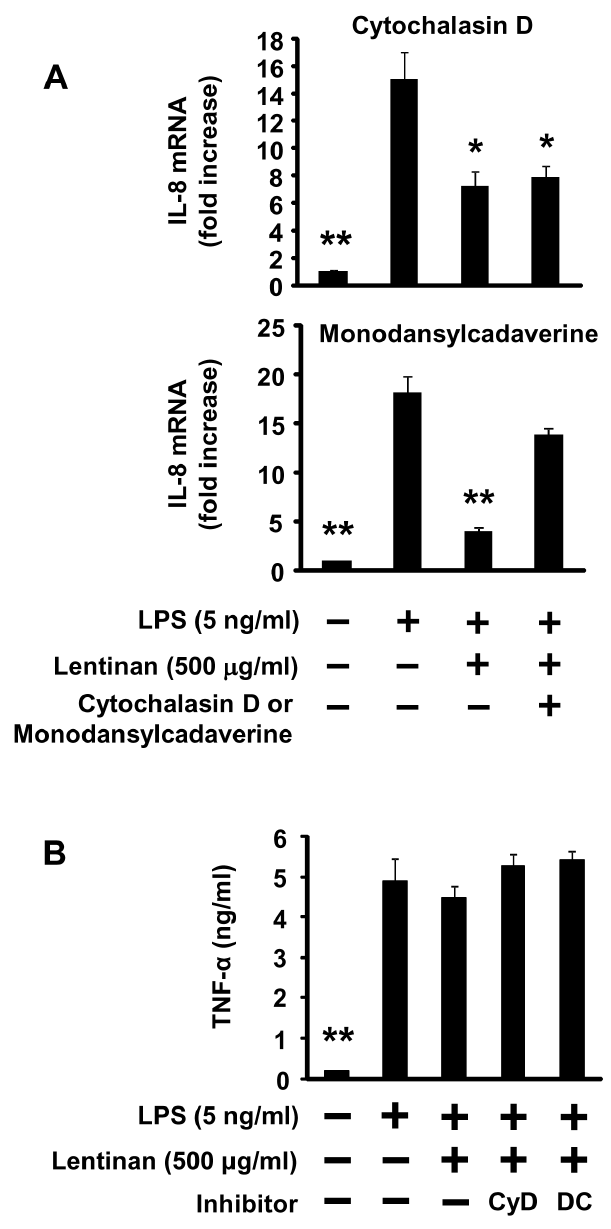
Figure 5. Effect of endocytosis inhibitors on lentinan inhibition of IL-8 mRNA expression in Caco-2 cells. Before co-culturing with RAW264.7 cells, Caco-2 cells on transwell membrane were treated with endocytosis inhibitors, cytochalasin D (2 m M) or monodansylcadaverine (100 m M), for 30 min. Caco-2 cells were washed three times with PBS, and then the cells were used in a co-culture model. Lentinan (500 m g/ ml) was added into the apical compartment of a co-culture model for 3 h. Subsequently, LPS was added to the basolateral compartment at a concentration of 5 ng/ml, followed by incubation for an additional 3 h. IL-8 mRNA expression in Caco-2 cells was determined by quantitative RT-PCR. (B) TNF- a production in the basolateral compartment was determined by a L929 cytotoxicity assay. The values represent the means 6 SE. Experiments were repeated for three times in triplicate. * P , 0.05, ** P , 0.01 vs. LPS